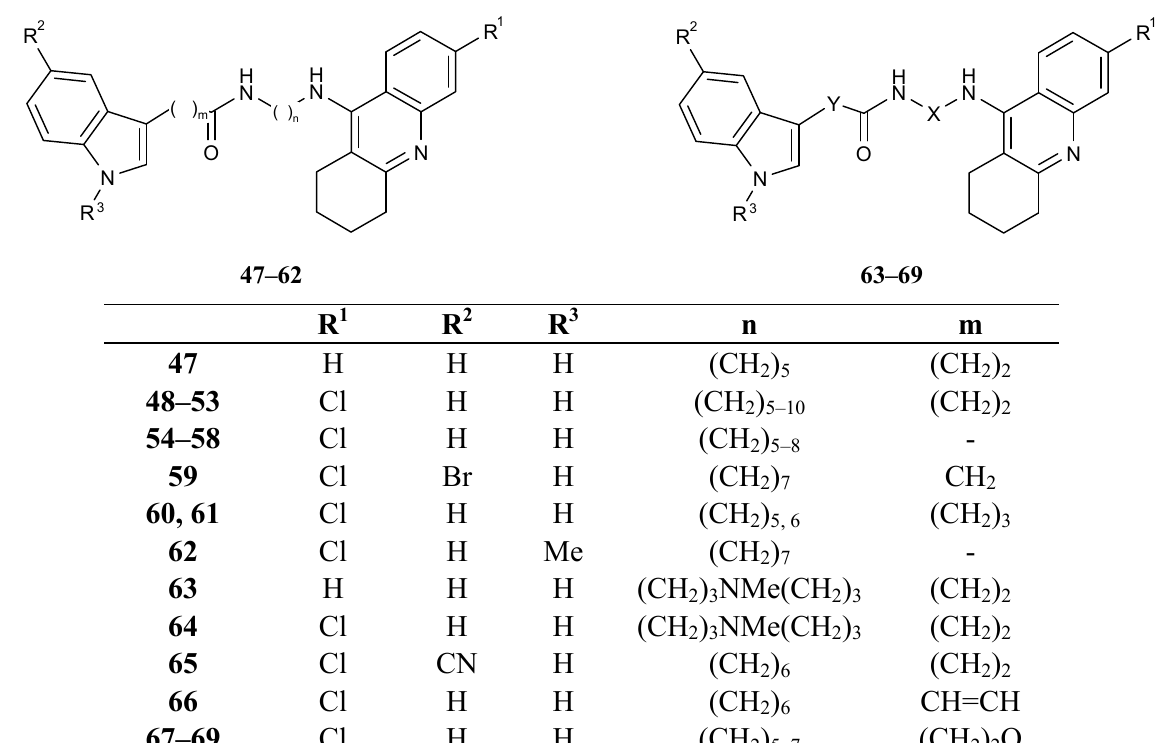
Figure 14. Tacrine-indole heteroligands 47–69